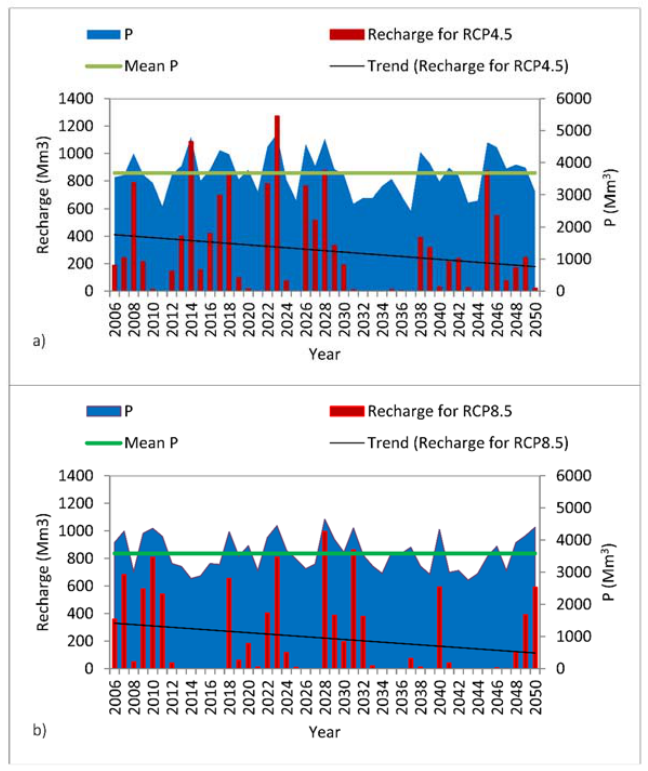
Figure 6. Estimated recharge (Mm 3 ) and annual precipitation (Mm 3 ) for scenarios ( a ) RCP4.5 and ( b ) RCP8.5 in the Klela basin from 2006–2050. The lines are linear regressions of trends in recharge and mean annual precipitation against time.